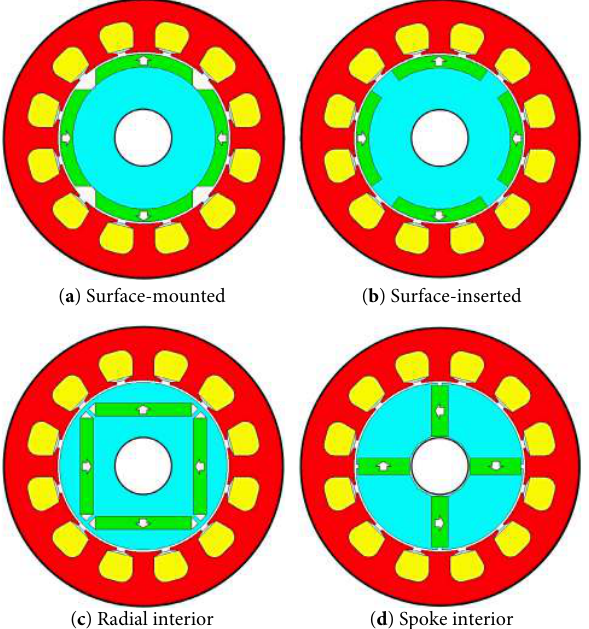
Fig. 11 Alternative PMSM topologies with different types of PM array.